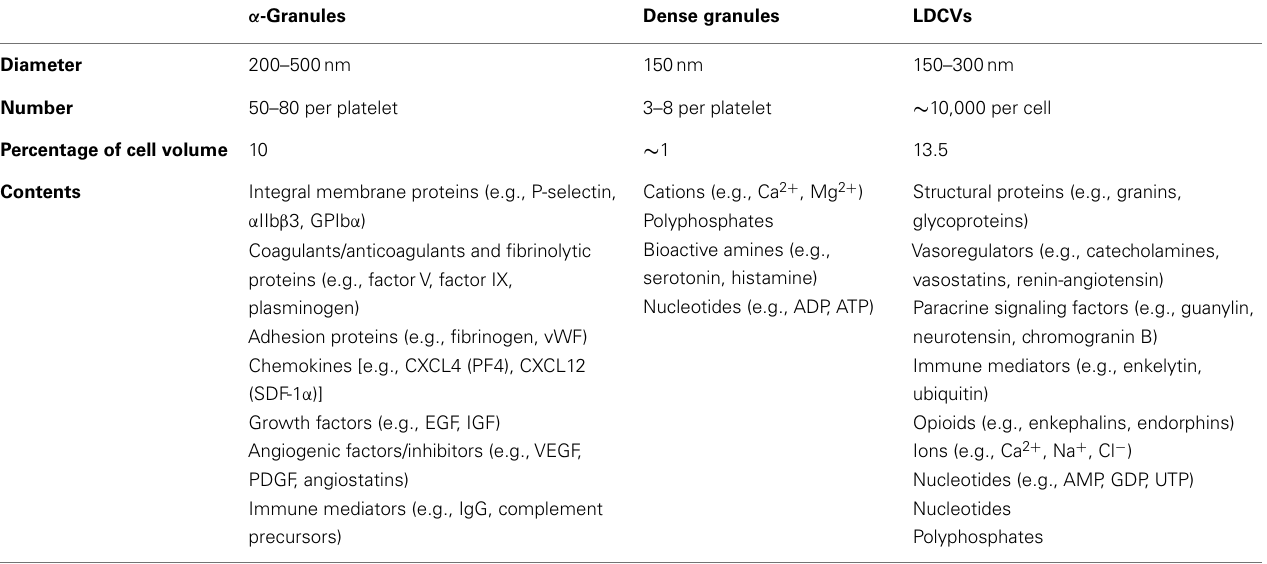
Table 2 | Comparison of granule types contained in platelets and chromaffin